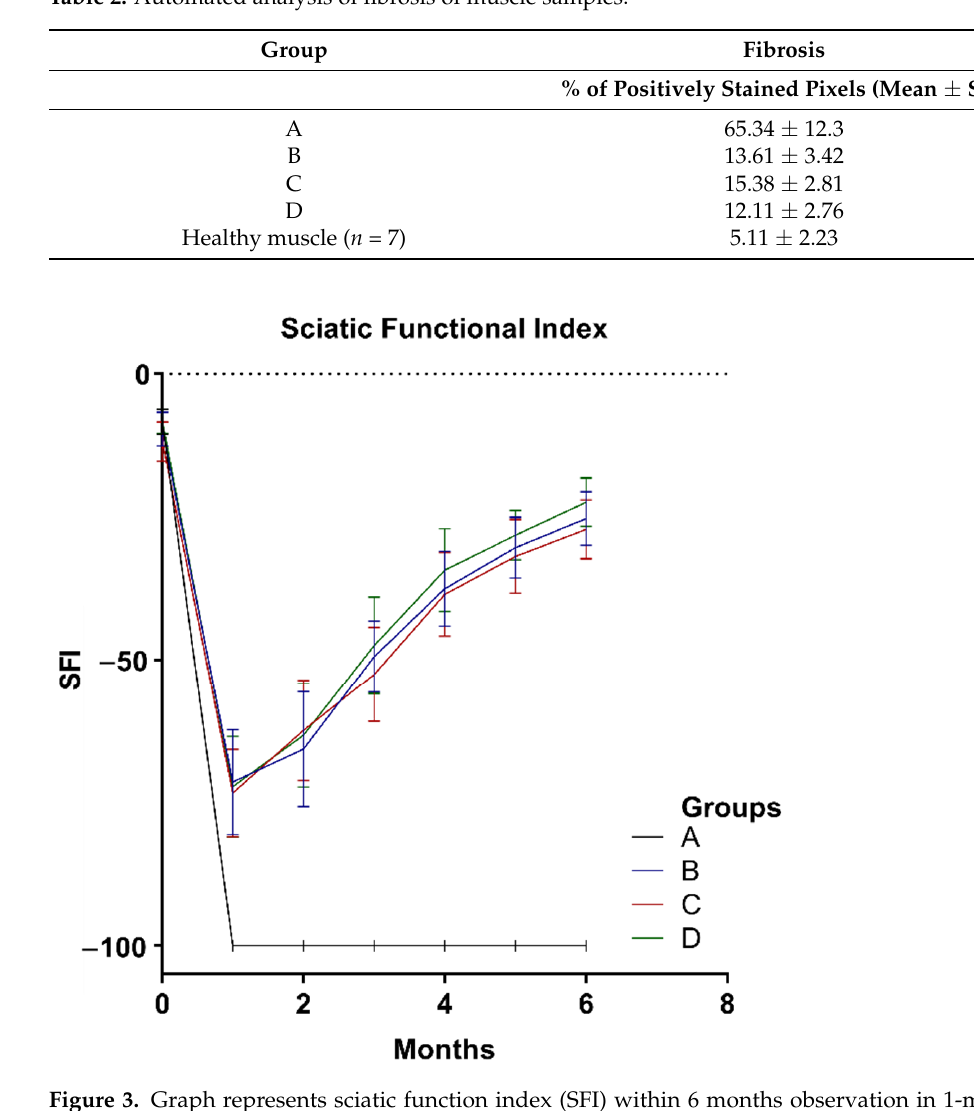
Figure 2. ( A ) Metabolic activity of ASCs cultured on P(LLA-CL)-PANI and P(LLA-CL)-COL-PANI electrospun fibrous meshes; ( B ) Neurod 1 gene expression during the neurogenic differentiation of ASCs on P(LLA-CL)-PANI, P(LLA-CL)-COL-PANI and plastic plate (positive control). Negative control—ASCs cultured on plastic without differentiation medium; Significant difference: ** p < 0.01; **** p < 0.0001.